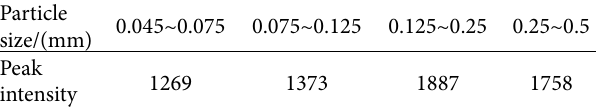
Table 5: SiO peak intensity of fly ash with different particle 2